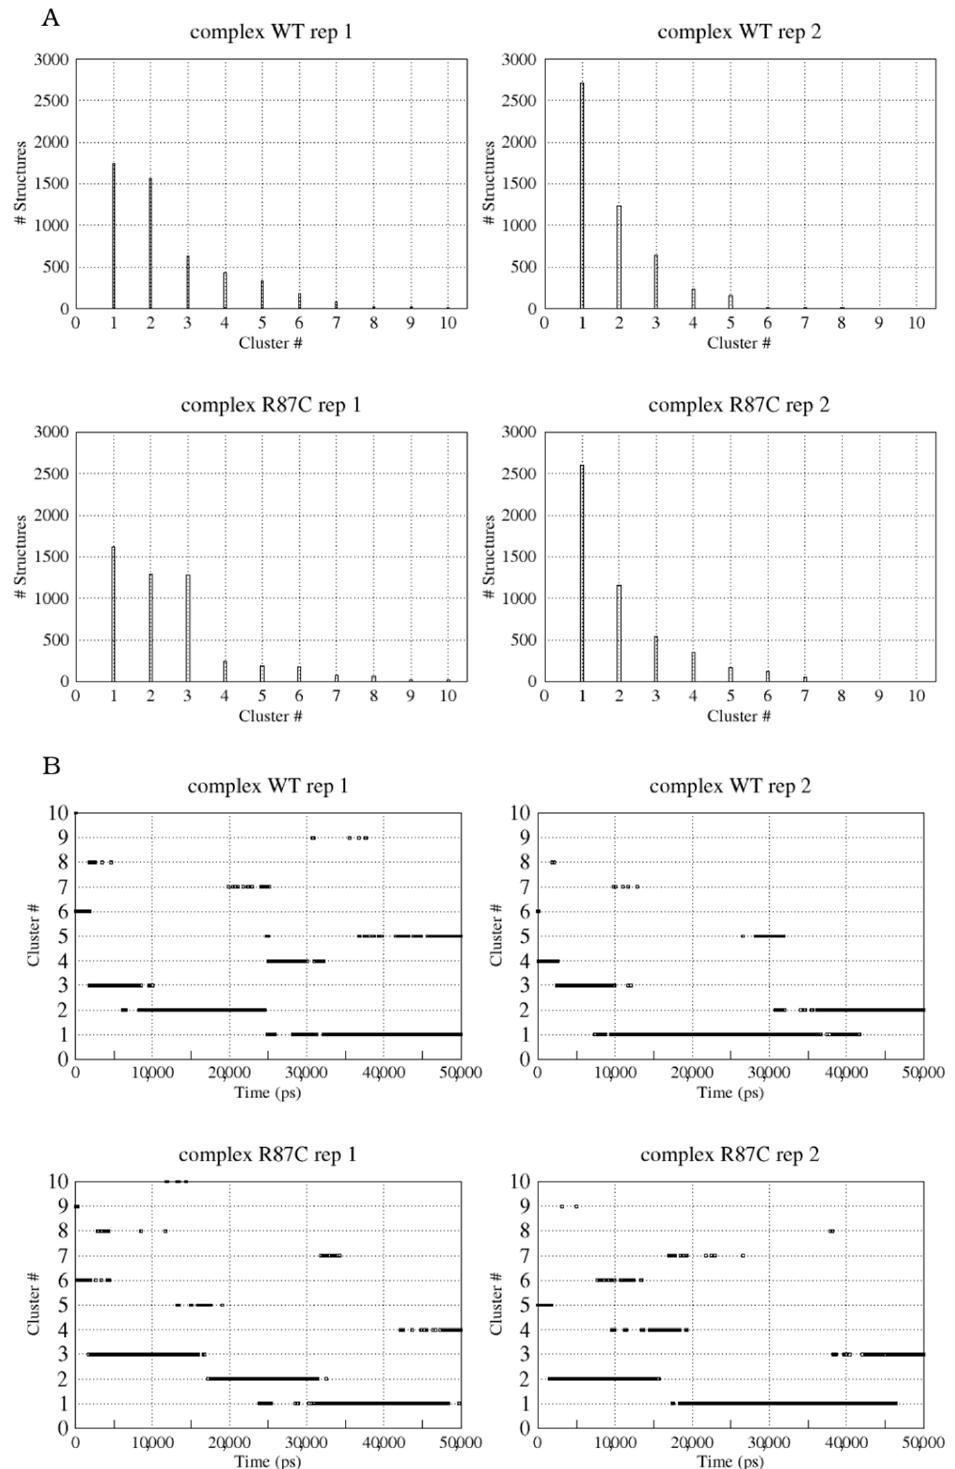
Figure 3. Cluster grouping of structures for first and second replicas of the WT and R87C complex MD simulations. The number of frames grouped in each cluster ( A ). Time evolution of each cluster ( B ). A threshold value of 0.3 nm was used for clustering.